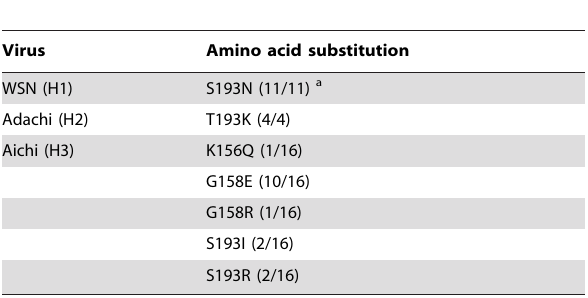
Table 2. Amino acid substitutions found in HA of WSN, Adachi, and Aichi escape